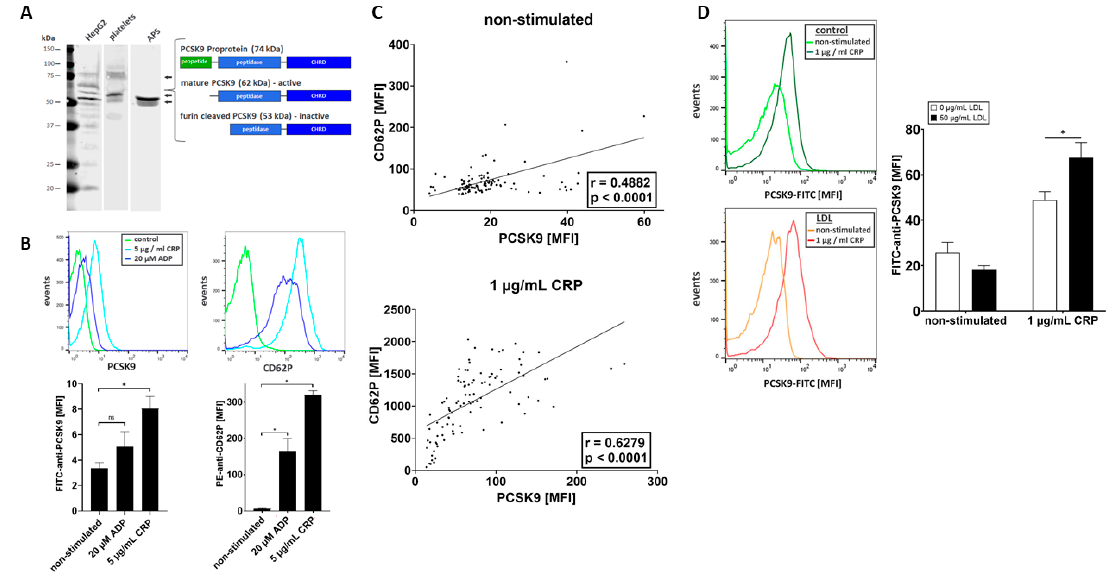
Figure 1. Release of PCSK9 from activated platelets. ( A ) Representative immunoblot images of PCSK9 expression in HepG2 cells, human platelets, and APS (CRP-stimulated, 5 µg/mL) from three independent experiments. ( B ) Platelet degranulation and release of PCSK9 was verified by surface expression of P-selectin (CD62P) using fluorochrome-conjugated PE-anti-CD62P and FITC-anti-PCSK9 antibodies by flow cytometry. Representative immunohistograms of three independent experiments are shown. PCSK9 signal was not significantly increased after ADP stimulation compared to non-stimulated platelets ( n = 3), but CRP stimulation resulted in a statistically significant increase in anti-PCSK9-FITC binding (plotted: mean ± SEM; n = 4, Mann–Whitney test, ns = not significant, * p < 0.05). ( C ) Correlation of platelet activation and PCSK9 expression. Surface expression of CD62P and of PCSK9 on non-stimulated (upper panel) or CRP-stimulated platelets (1 µg/mL) (lower panel) were determined by flow cytometry. Data indicate Pearson’s correlation coefficient. ( D ) Effect of LDL on surface expression of PCSK9 on platelets. PRP was incubated with or without 50 µg/mL LDL and thereafter stimulated with CRP (1 µg/mL) or left unstimulated and stained with PCSK9-FITC and analyzed by flow cytometry. Left panel: representative immunofluorescence histograms of three independent experiments are shown. Right panel: LDL treatment had a significant effect on the PCSK9 expression on CRP stimulated platelets (plotted: mean ± SEM, n = 6, Mann–Whitney test, * p < 0.05).